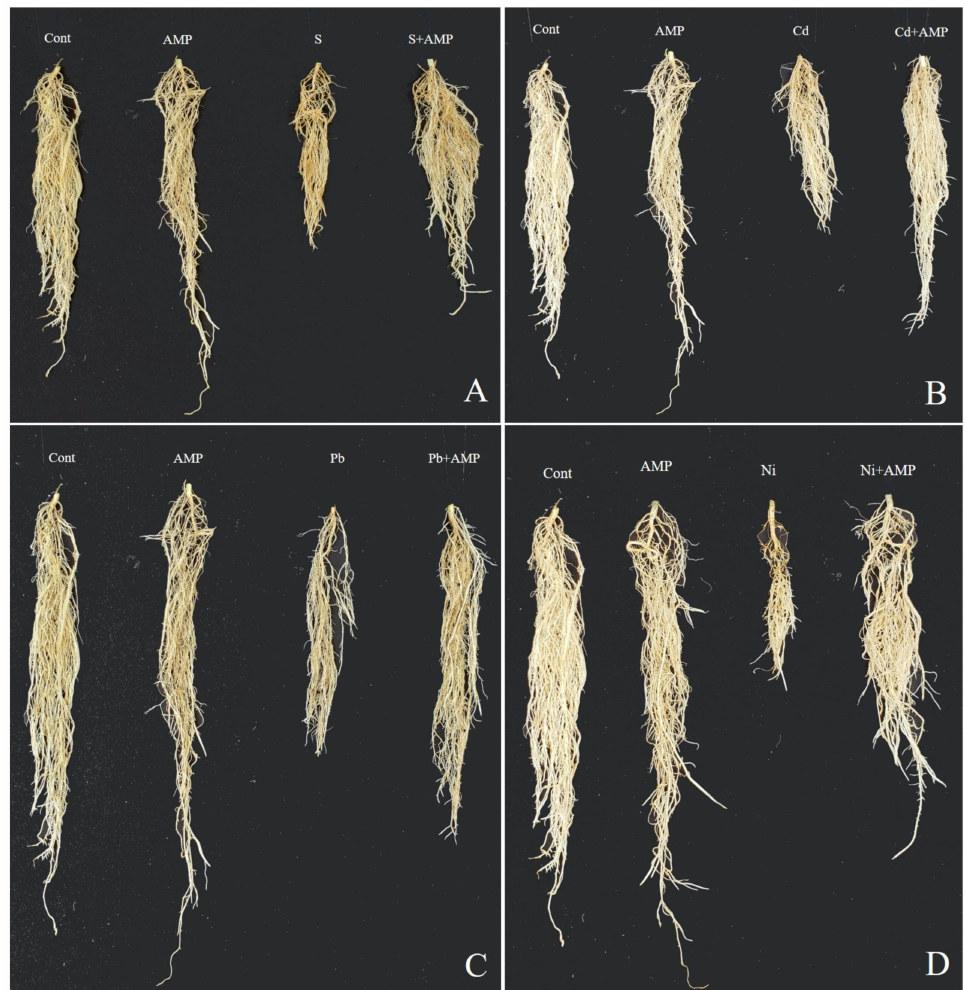
Figure 2. Effects of ampelopsin application on soybean plant roots under normal and stress conditions after 12 days of treatment (12DAT; ( A–D )). Treatments: Cont (control), AMP (1 µ M ampelopsin), S (1.5% sodium chloride), AMP (1 µ M ampelopsin) + S (1.5% sodium chloride), Cd (3 mM cadmium), 1 µ M AMP (ampelopsin) + Cd (3 mM cadmium), Pb (3 mM lead), AMP (1 µ M ampelopsin) + Pb (3 mM lead), Ni (3 mM nickel), and AMP (1 µ M ampelopsin) + Ni (3 mM nickel). Values show the means ± SE ( n = 5) and significant differences at p < 0.05 (Tukey